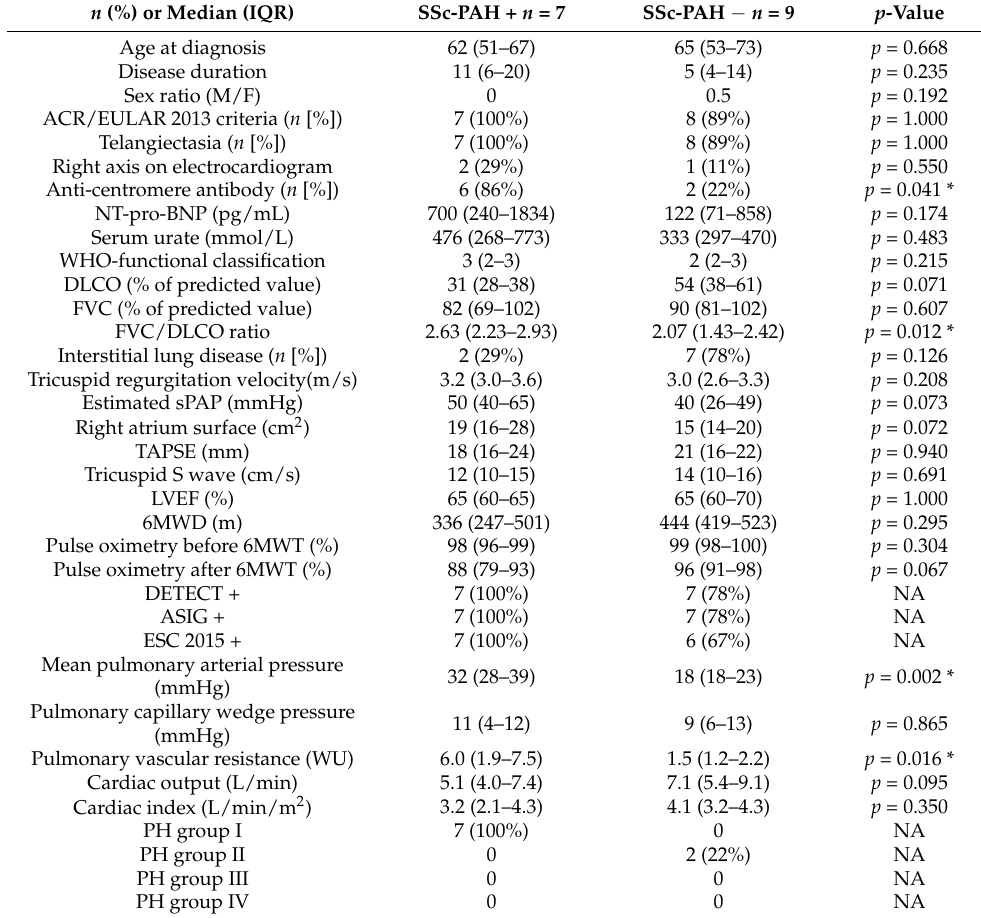
Table 3. Characteristics of patients in whom right heart catheterization was performed based on MDT